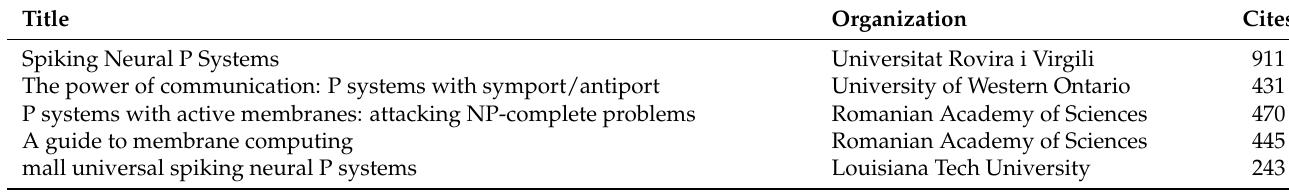
Table 6. Representative papers in the field of membrane